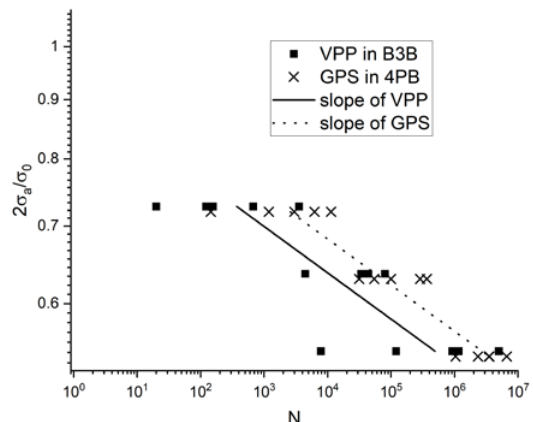
Figure 8. Cyclic fatigue-adjusted S-N data and normalized stress amplitude to critical stress for via vat photopolymerization manufactured (VPP) binder based Si3N4 (adapted and redrawn from Ref. [24] 2022 Elsevier Ltd.), in comparison to gas pressure sintered (GPS) high strength Si3N4 (adapted and redrawn from Ref. [49] 2020 Elsevier Ltd.).